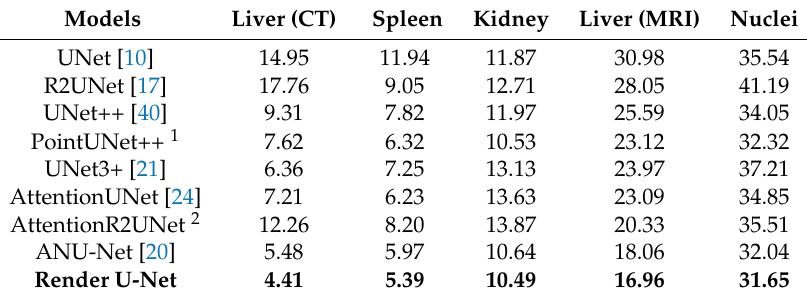
Table 7. Hausdorff distance of five segmentation